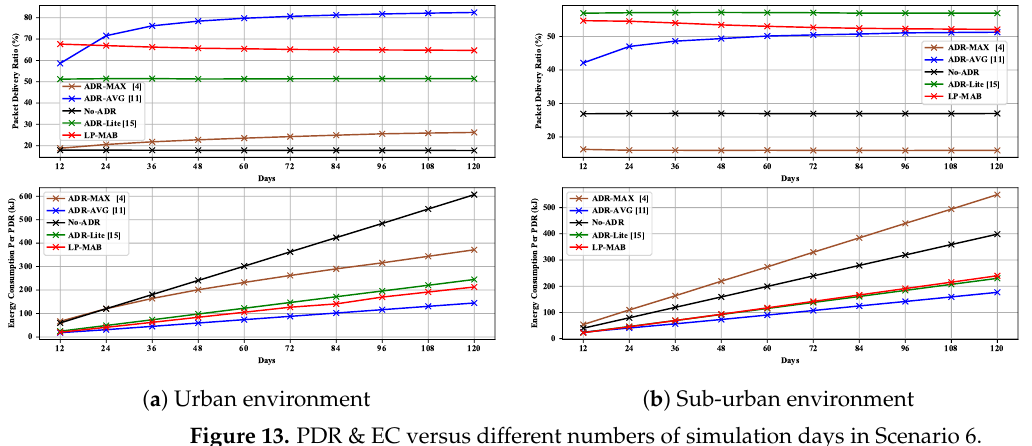
Figure 13. PDR & EC versus different numbers of simulation days in Scenario